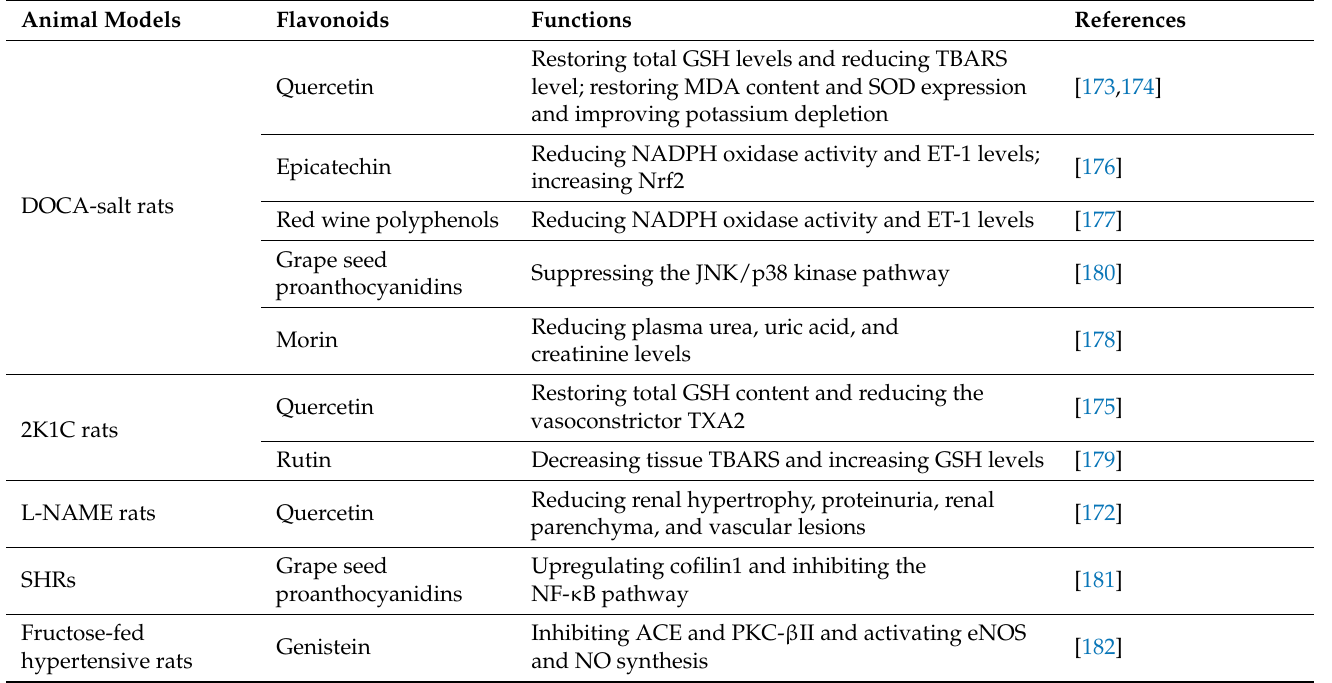
Table 3. Flavonoids in hypertensive